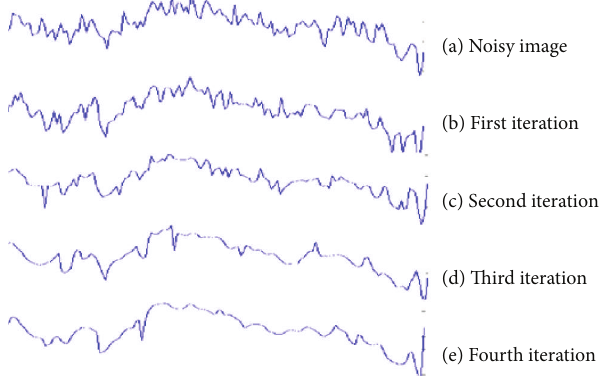
Figure 21: Family of 1D signals showing the plot of only one particular row of an image, the variation of which is shown at different iterations, starting from noisy to final denoised